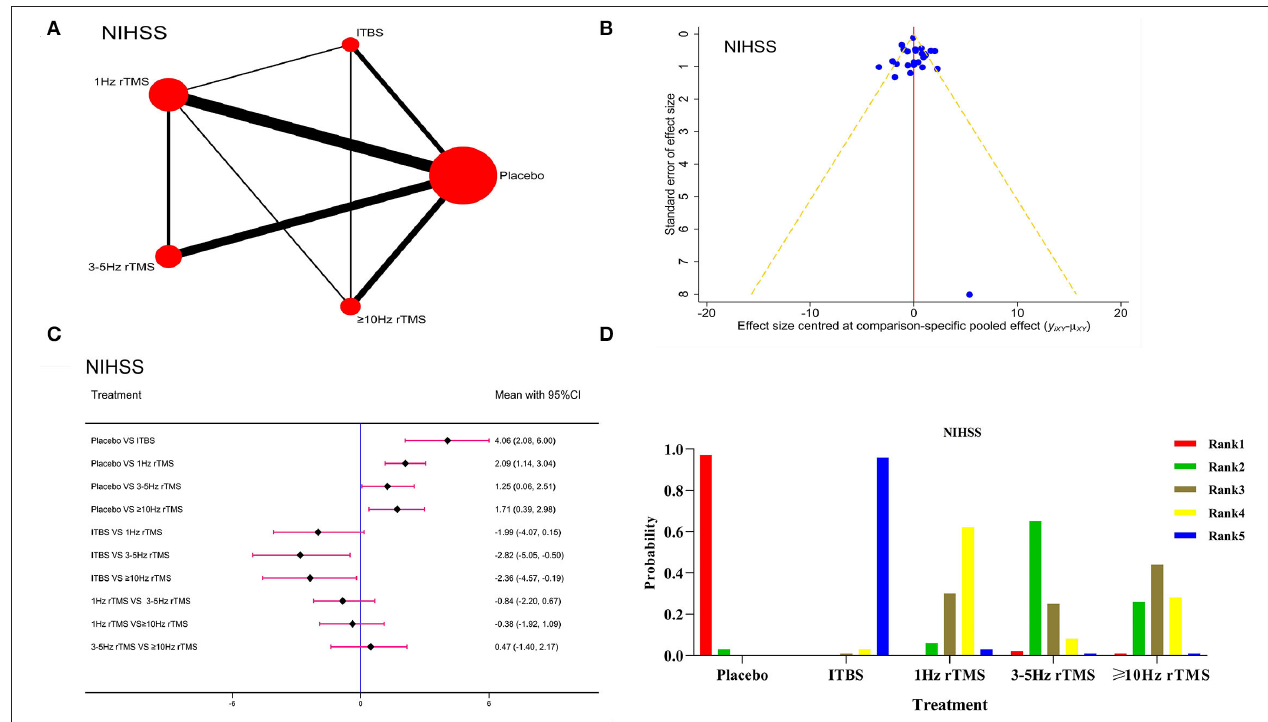
FIGURE 5 | Network meta-analysis results for the National Institute of Health stroke scale (NIHSS). (A) : Network plot; (B) : Funnel plot; (C) : Forest plot; (D) : The figure of ranking